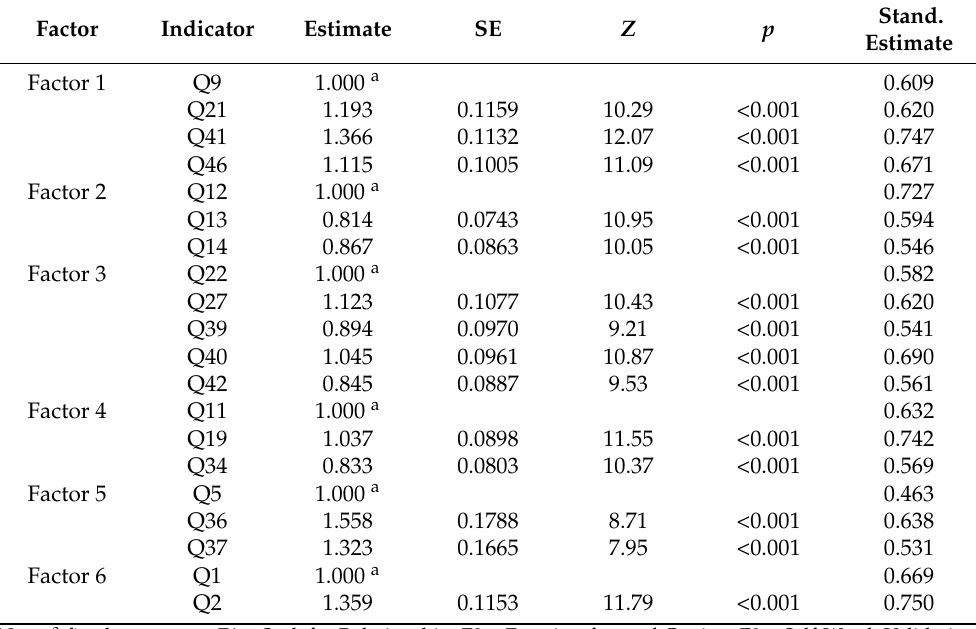
Table 5. CFA factor loadings.